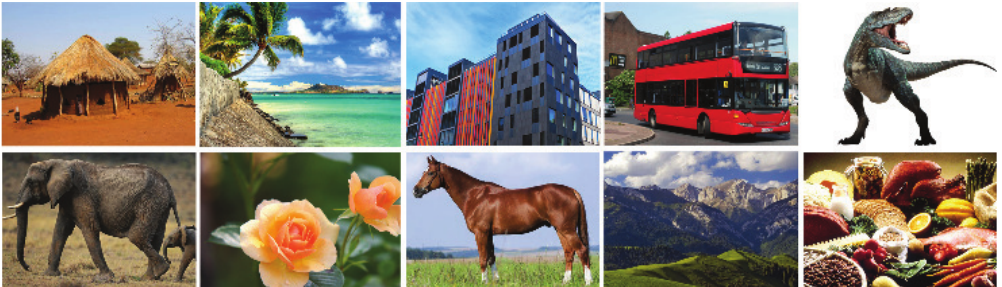
Figure 3. Sample images of each category of Corel set